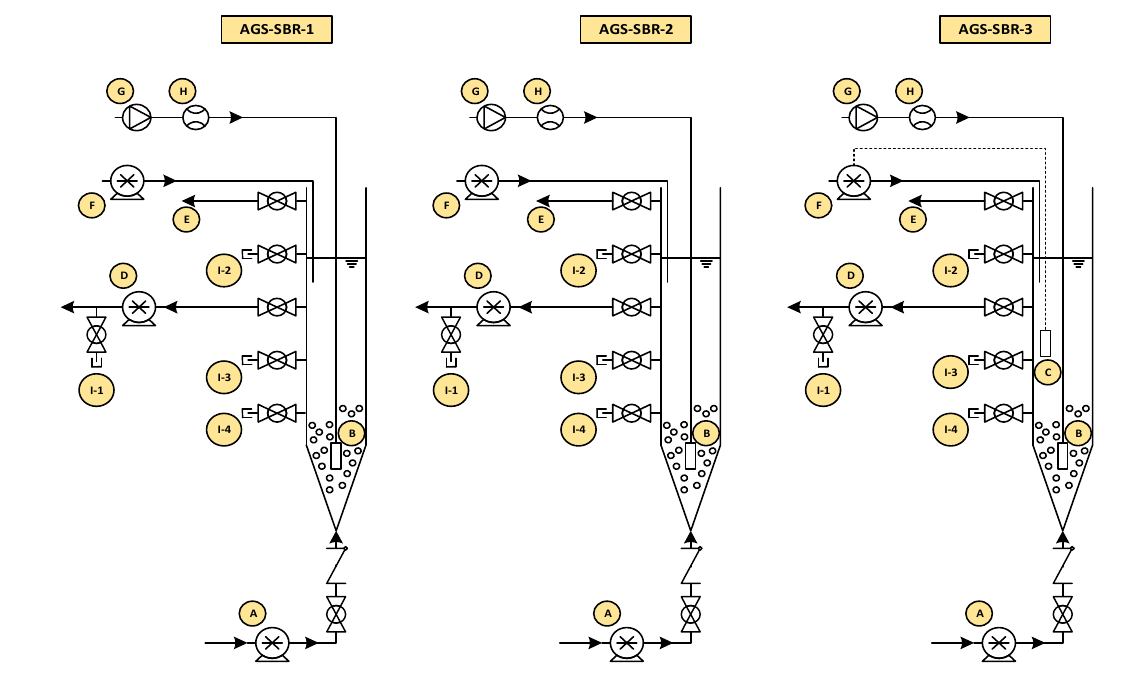
Figure 1. Schematic of AGS-SBR-1, AGS-SBR-2, and AGS-SBR-3: (A) feed pump, (B) air diffuser, (C)